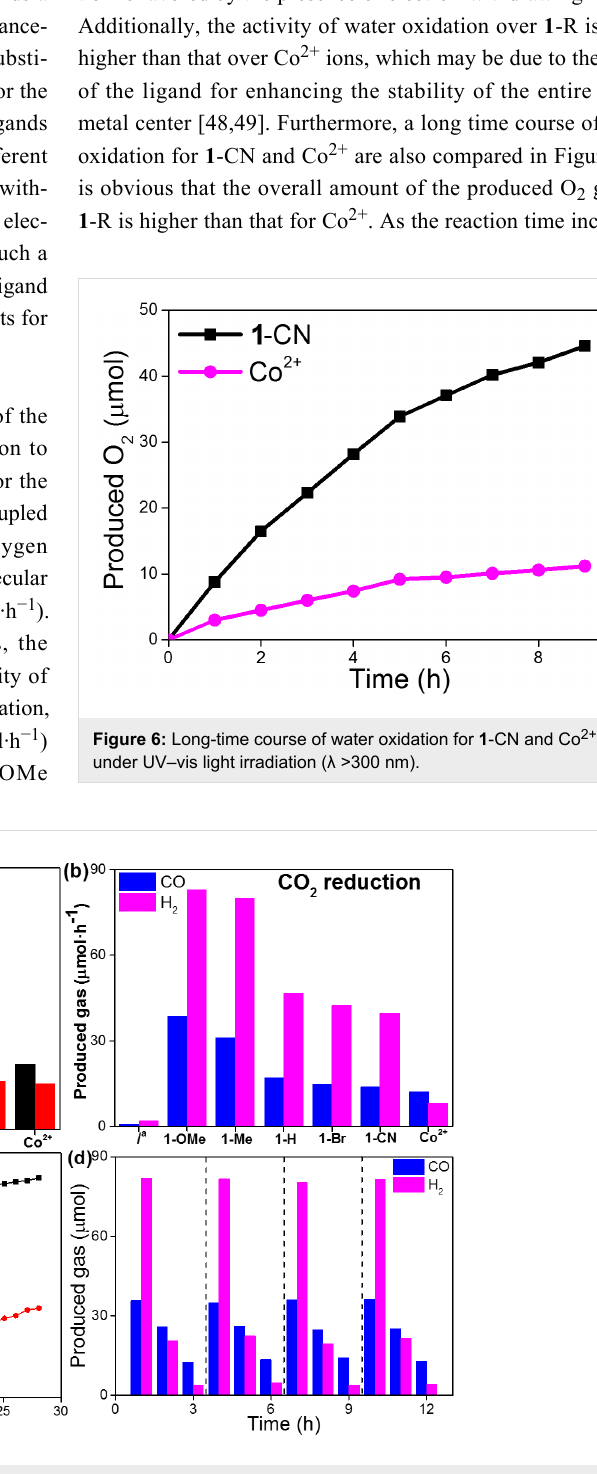
Figure 5: The activity of 1 -R for (a) water oxidation and (b) CO 2 reduction. (c) Long-time course of water oxidation for 1 -CN under UV–vis light irradia- tion ( λ > 300 nm) in two recycling tests. (d) CO 2 reduction for 1 -OMe under visible light irradiation ( λ > 420 nm) in four recycling tests. a Without 1 -R.